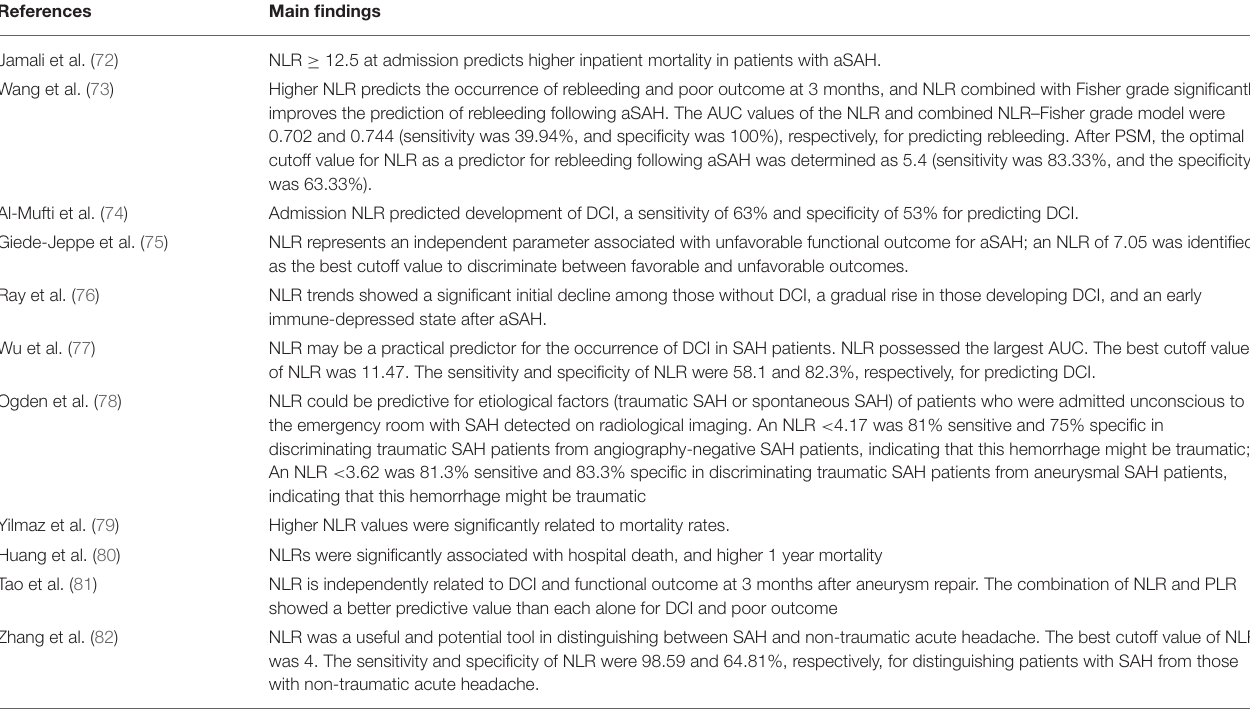
TABLE 3 | Synthesis of the main